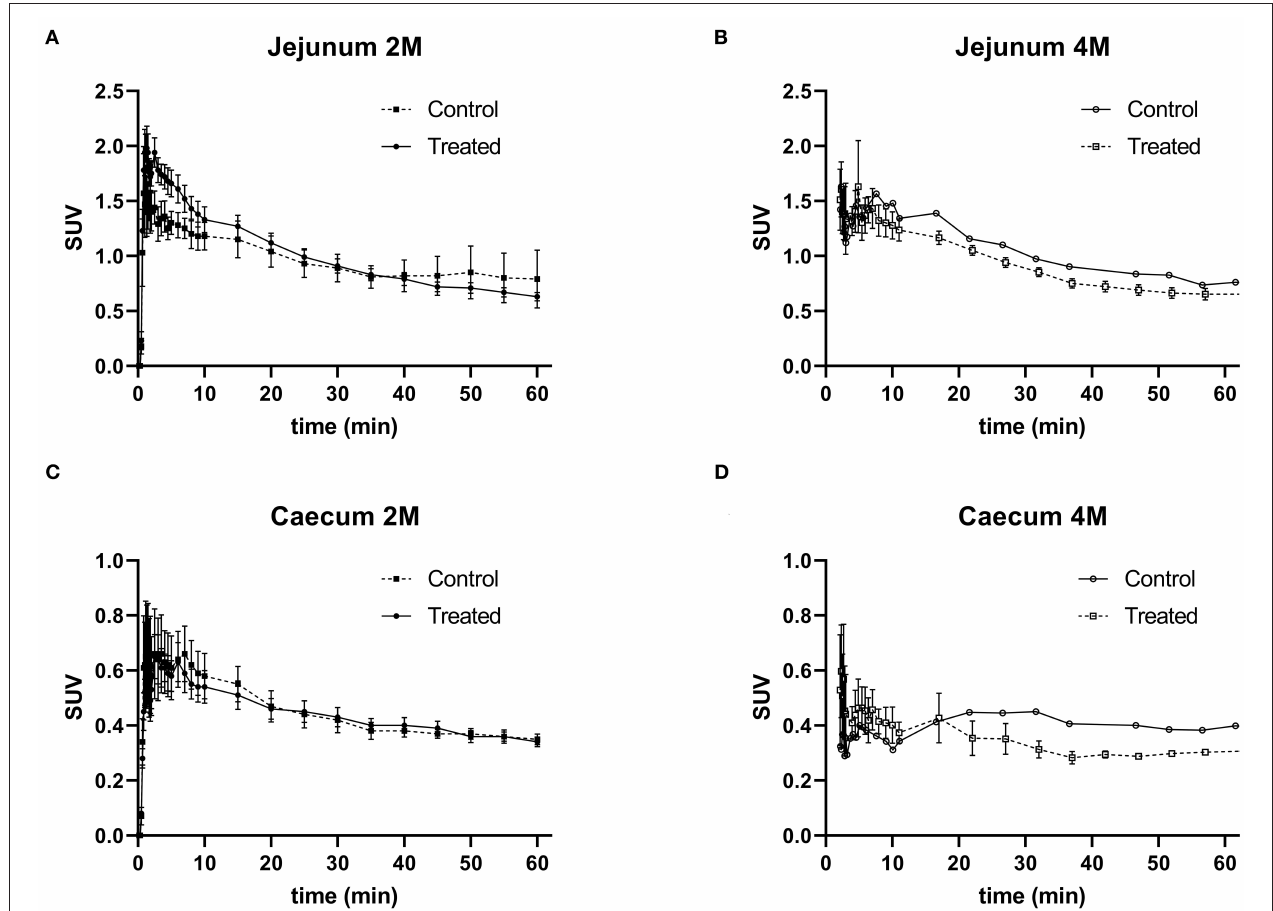
FIGURE 14 | (–)-[ 18 F]Flubatine-PET imaging of enteric α 4 β * 2 nicotinic acetylcholine receptor density after 4 months exposure to rotenone. Time-activity curves of the jejunum after exposure to rotenone of 2 months (2M) (A) or 4 months (4M) (B) ; time-activity curves of the caecum after exposure to rotenone of 2 months (2M) (C) or 4 months (4M) (D) ; after injection of (–)-[ 18 F]Flubatine in C57/BL6J mice control or treated. Error bars represent